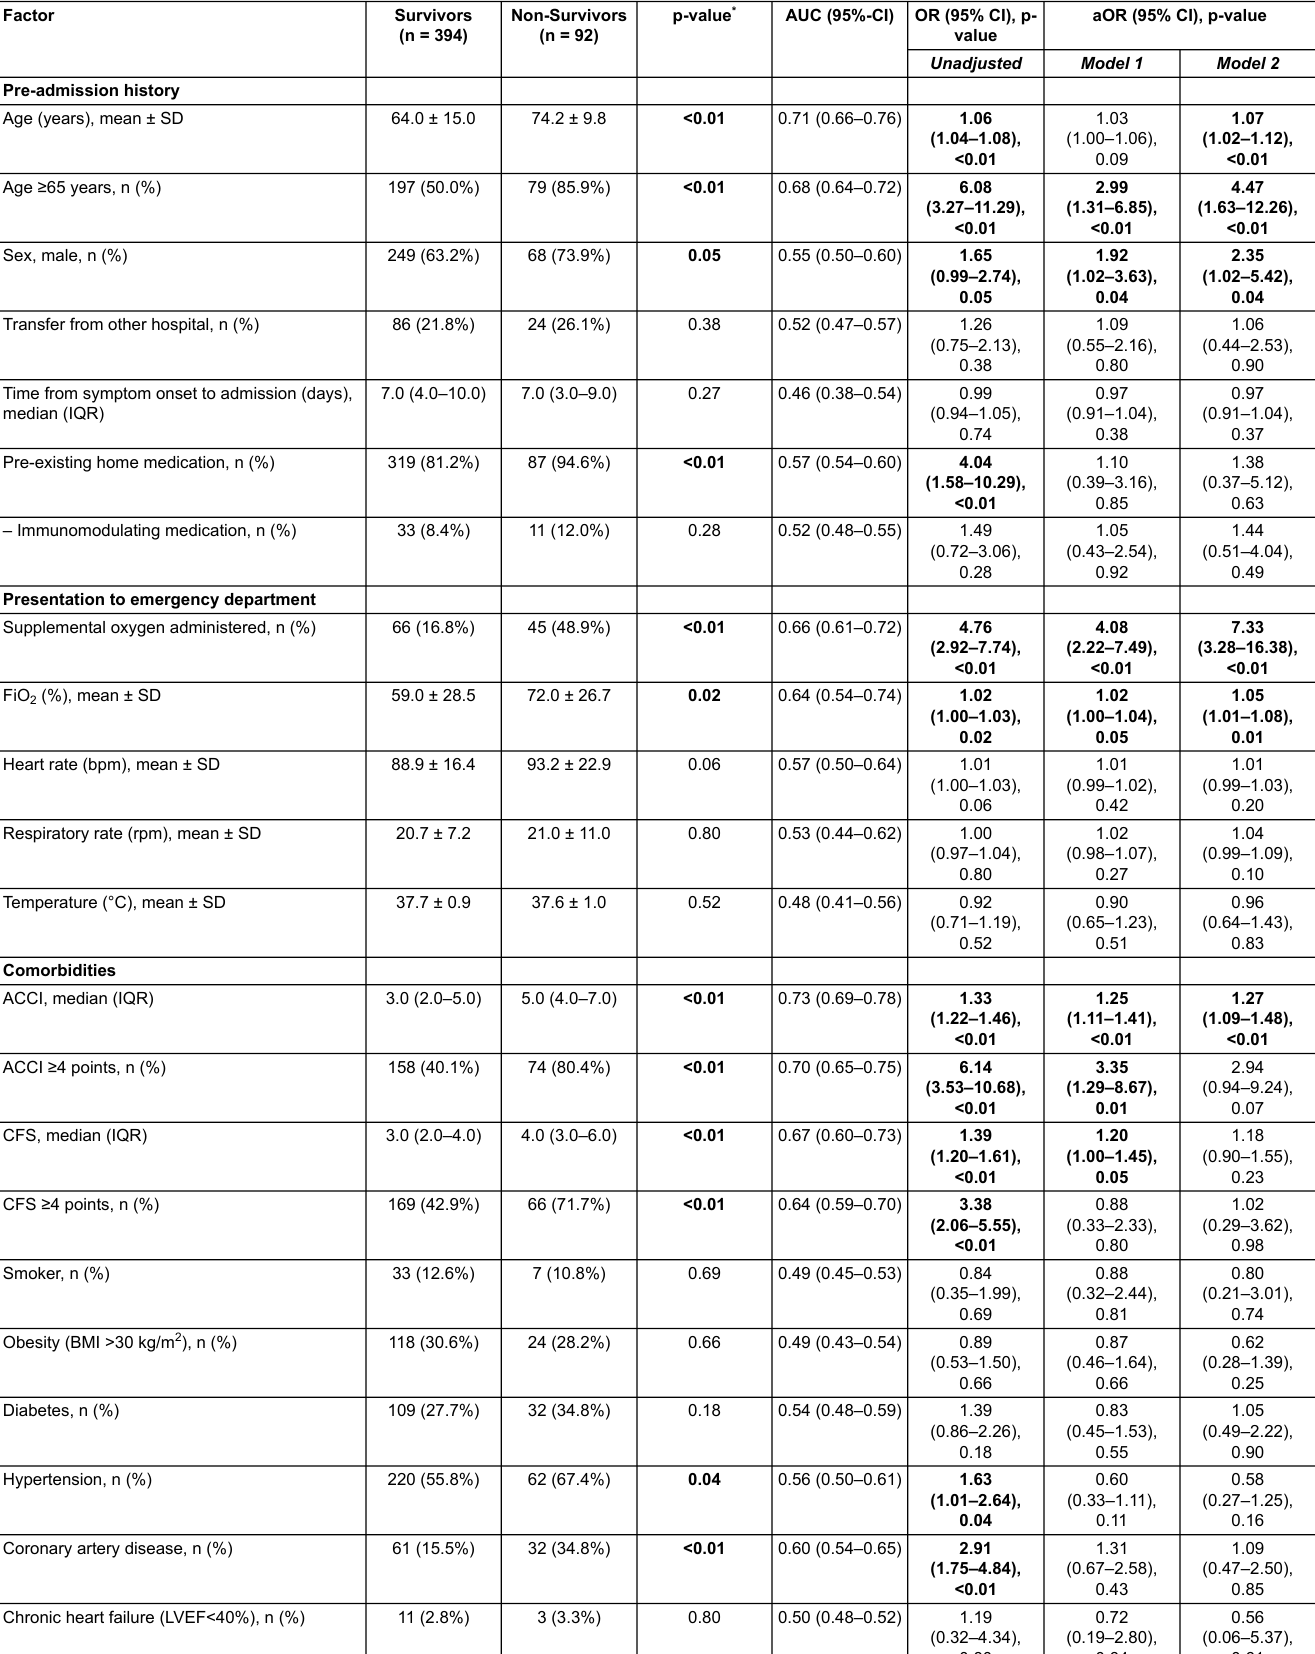
Table S2: Association of baseline characteristics and vital signs upon admission stratified by all-cause in-hospital